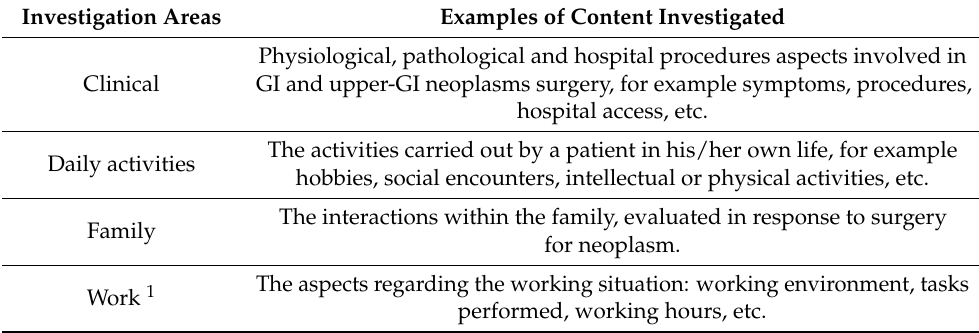
Table 2. Description of the four investigation